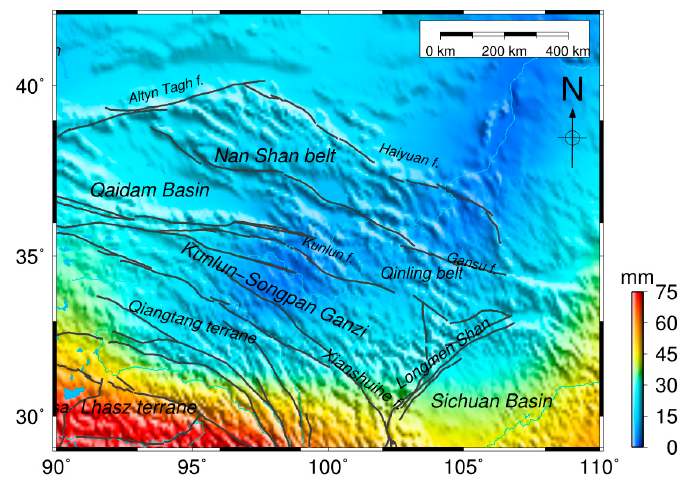
Figure 4. Amplitudes of seasonal signals showing peak-to-peak surface mass variations (water-equivalent height) derived from GRACE in northeastern Tibet, which is shown as the box in Figure 3. The gray solid lines indicate active major strike-slip faults.